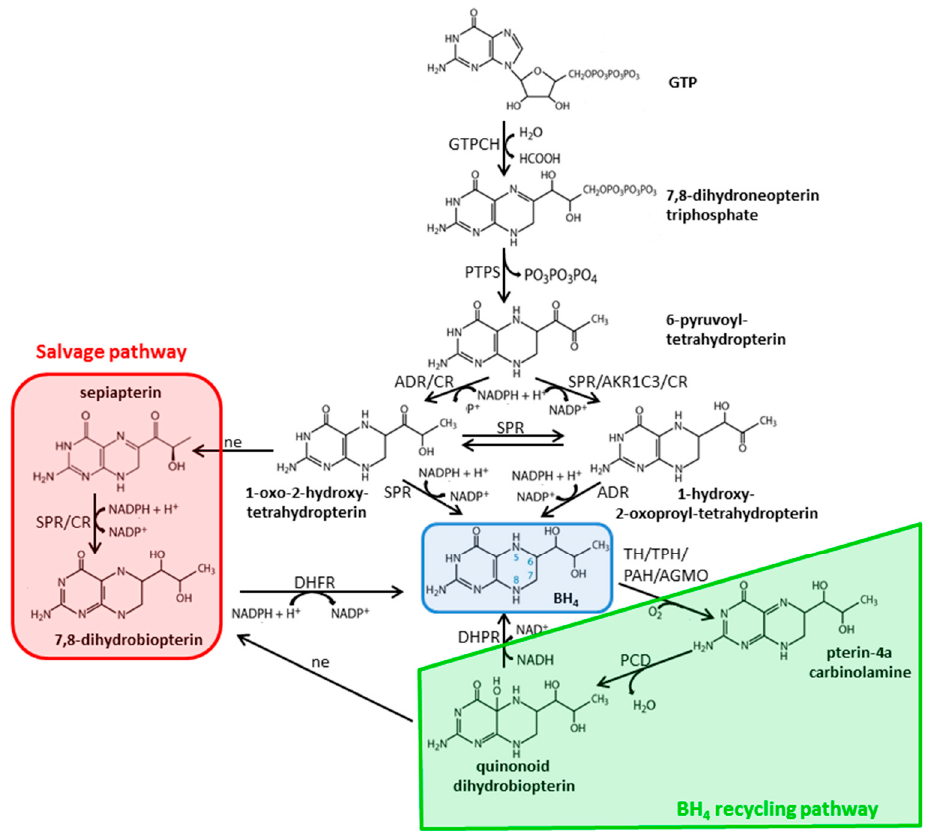
Figure 3. Biosynthesis and recycling of BH 4 . ADR, aldose reductase; AGMO, alkylglycerolether monooxygenase; AKR1C3, 3 α -hydroxysteroid dehydrogenase type 2; BH 4 , 5,6,7,8 tetrahydrobiopterin; CR, carbonyl reductase; DHFR, dihydrofolate reductase; DHPR, dihydropteridine reductase; GTP, guanosine triphosphate; GTPCH, GTP cyclohydrolase 1; H 2 O, water; NAD, nicotinamide dinucleotide; NADPH, nicotinamide dinucleotide phosphate; ne, non-enzymatic; O 2 , oxygen; PAH, phenylalanine hydroxylase; PCD, pterin-4-carbinolamine dehydratase; PTPS, 6-pyruvoyl tetrahydrobiopterin synthase; SPR, sepiapterin reductase; TH, tyrosine hydroxylase; TPH, tryptophan hydroxylase.